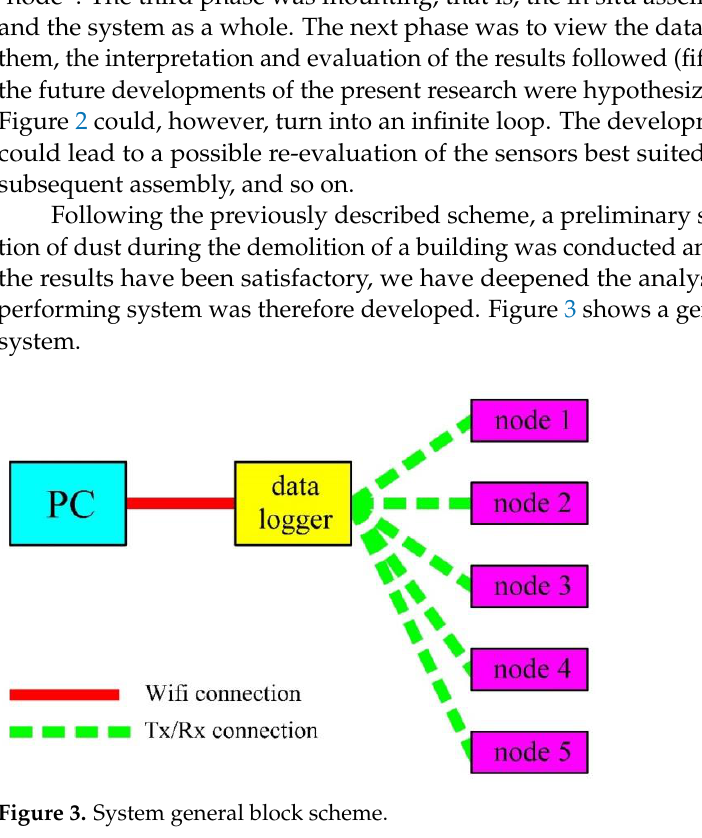
Figure 3. System general block scheme.